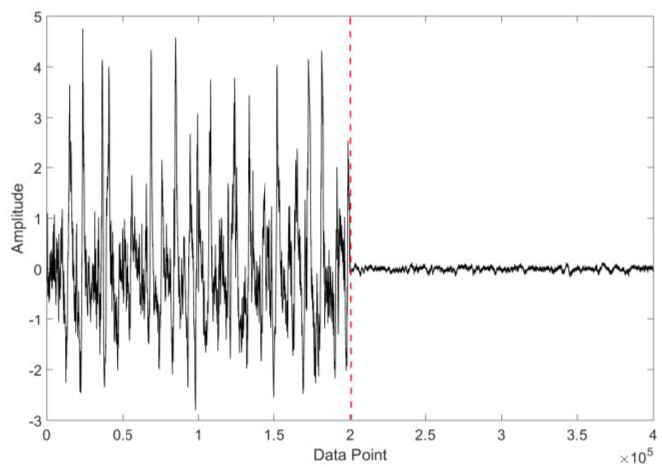
Figure 14. The signals in the low oil temperature and the high oil temperature.